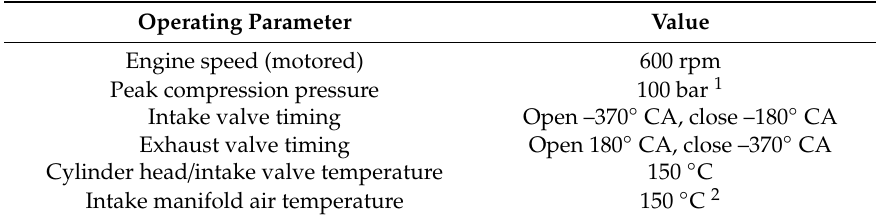
Table 4. Standard measurement conditions. Combustion TDC defined at 0 ◦ CA (crank